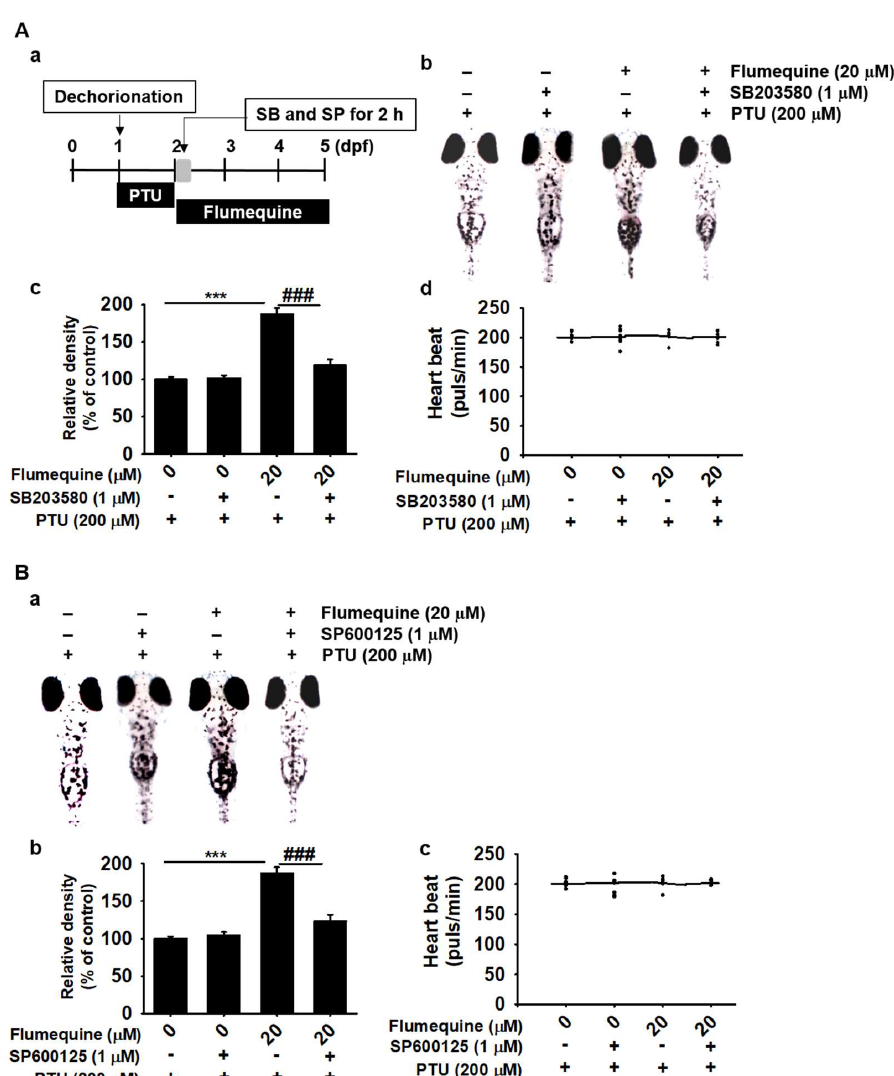
Figure 8. p38 MAPK and JNK upregulate melanogenesis in zebrafish larvae. ( A - a ) The chorion of zebrafish larvae ( n = 20) was removed at 1 dpf and treated with PTU (200 μM) for 24 h. Then, 2 dpf zebrafish larvae were treated with flumequine (20 μM) for 72 h followed by treatment with SB203580 (1 μM) or SP600125 (1 μM) for 2 h. ( A - b and B - a ) Images of 5 dpf zebrafish larvae were captured under a microscope (40×). ( A - c and B - b ) Relative density was calculated using the Image J software. ( A - d and B - c ) The average heart rate of zebrafish larvae ( n = 20) was measured to assess the toxicity of flumequine. Data are reported as the mean ± SEM of three independent experiments ( n = 3). ***, p < 0.001 vs. untreated control and ### , p < 0.001 vs. flumequine-treated group preincubated with PTU.